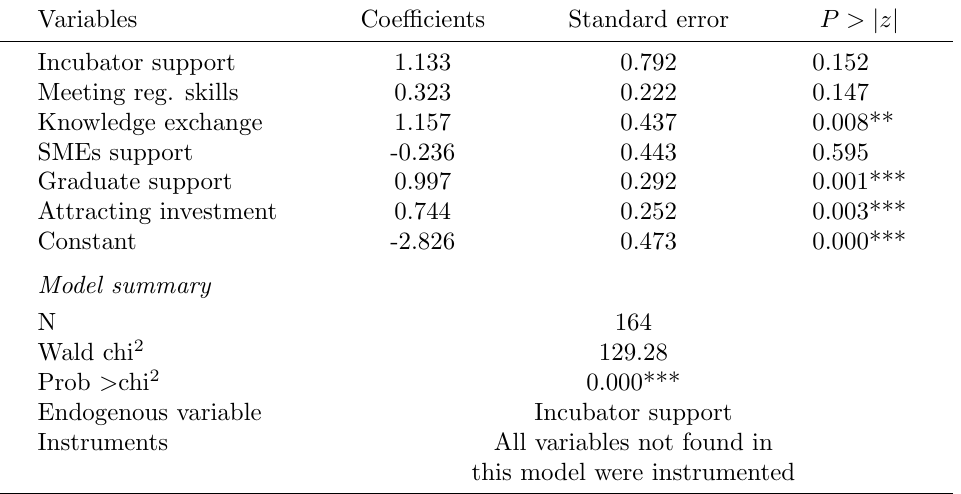
Table 2: Results of Wald test of